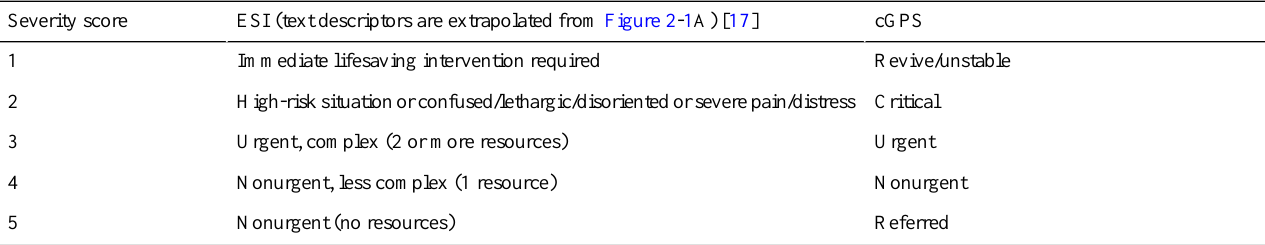
Table 1. Working definitions used to describe each level of